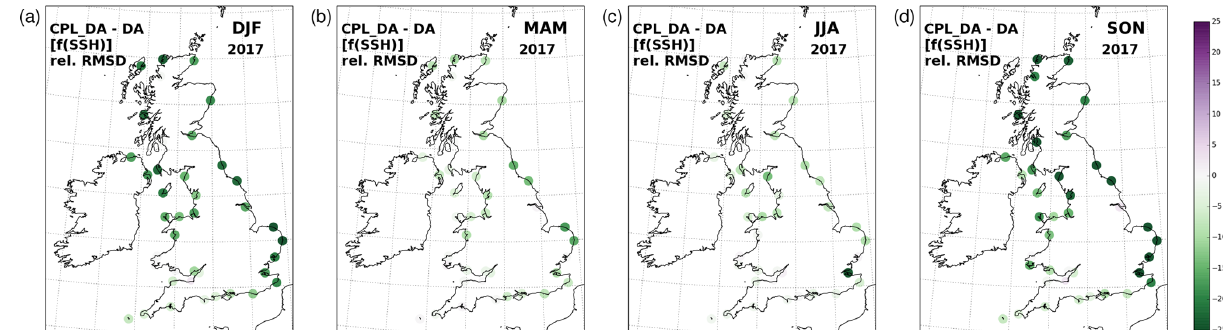
Figure 16. Percentage change in RMSD for Doodson-filtered SSH results from CPL_DA and DA, comparing all simulated data during 2017 with filtered in situ tide gauge observations around UK coasts. Positive differences (purple shading) indicate a relative degradation of performance with wave coupling, negative differences (green shading) indicate relative